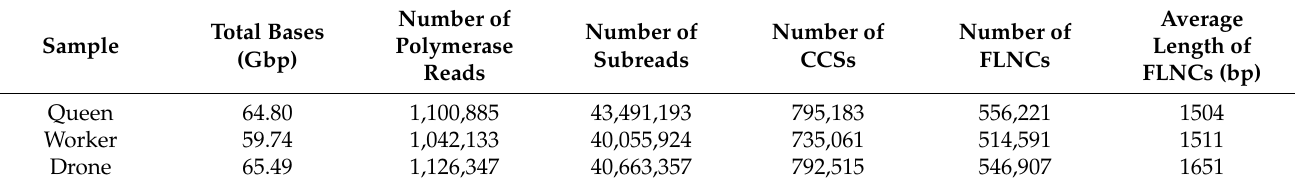
Table 1. Summary of the PacBio sequencing